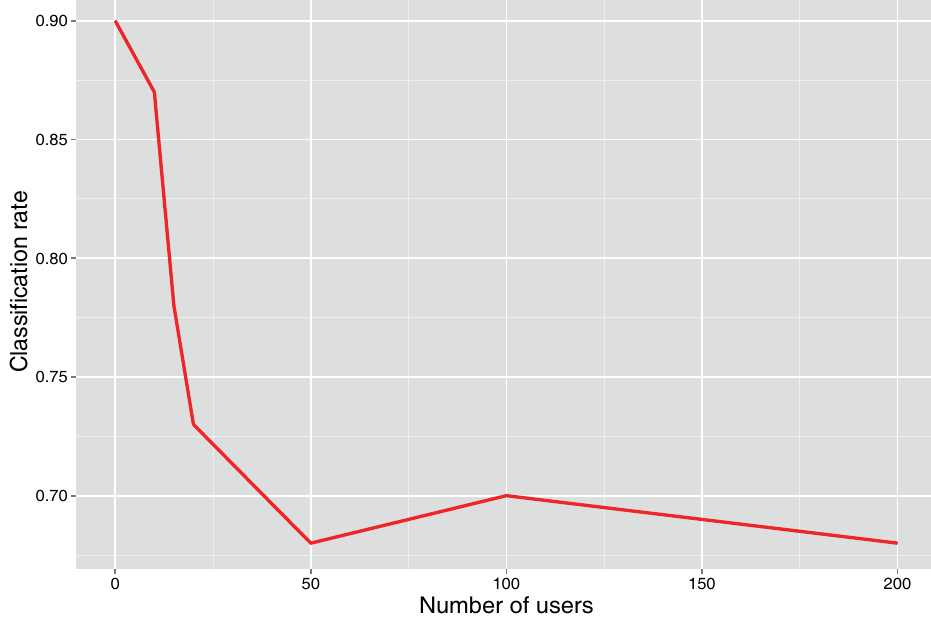
Figure 8. Classification rate vs. the number of